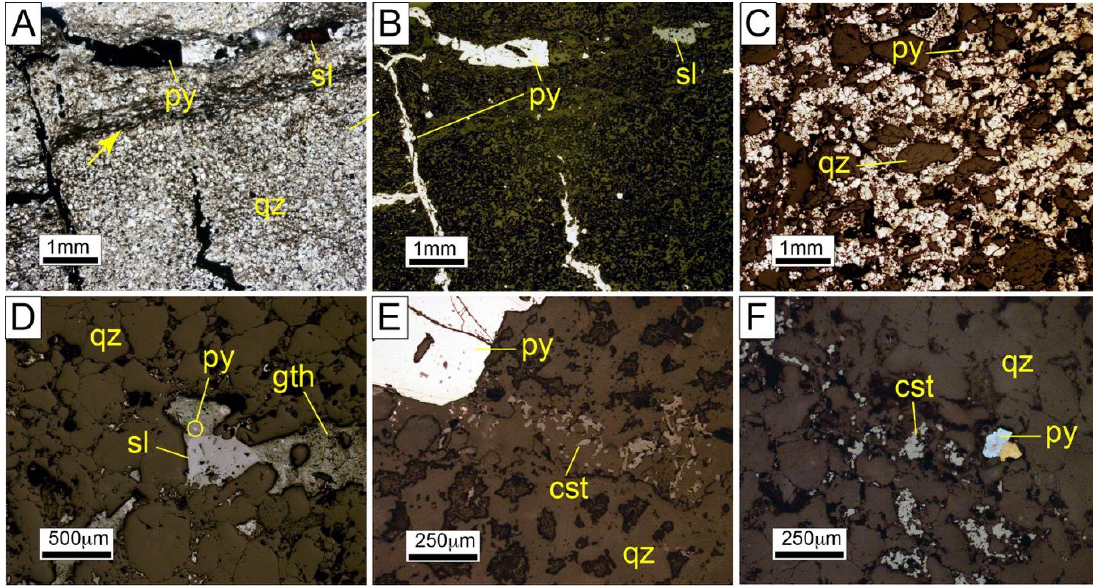
Figure 4. Photomicrographs of representative stratiform mineralization in the Huari Huari district. ( A,B ) Sulfide minerals in this sample form discontinuous veinlets, either parallel or perpendicular to bedding, or replace selective units (yellow arrow; transmitted plane polarized light ( A ) and reflected light ( B )). ( C ) Pyrite mineralization around rounded detrital quartz grains (reflected light). ( D ) Sphalerite and goethite in this sample occupy interstitial positions between rounded quartz grains (reflected light). ( E ) Cassiterite (needle tin variety) occurs along a narrow quartz veinlet in a sandstone host (reflected light). ( F ) Minute cassiterite crystals occupy the spaces between detrital quartz grains along with zoned pyrite crystals (notice that pyrite is tarnished on purpose to emphasize crystal zoning; reflected light). Abbreviations: cst = cassiterite; gth = goethite; sl = sphalerite; py = pyrite; and qz = quartz.